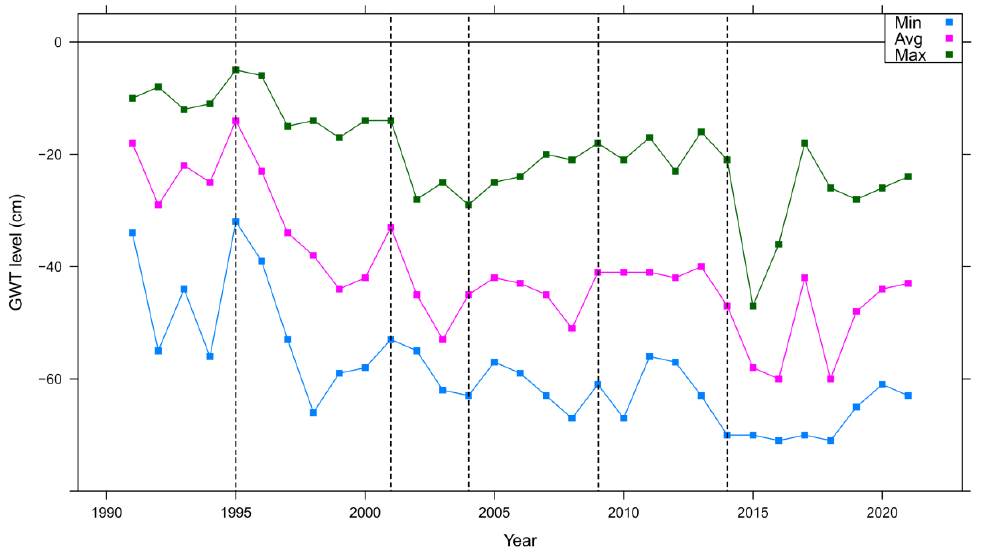
Figure 10. Mean (Avg), minimum and maximum GWT levels in respective years—the averages of the measurement points are depicted in the line. Dashed vertical lines show break years of the double mass